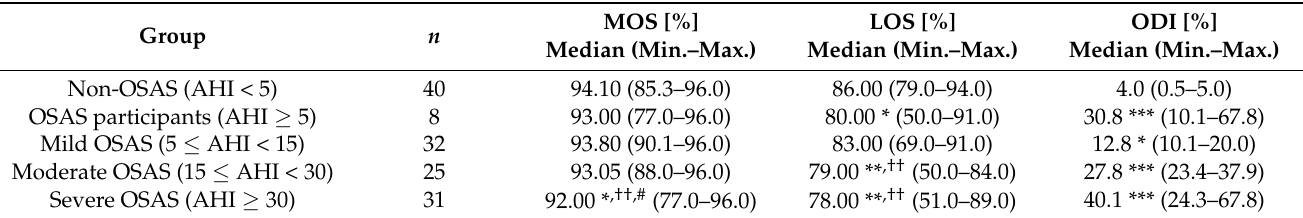
Table 4. Oxygen saturation level (MOS), lowest oxygen saturation level (LOS), and oxygen desaturation index (ODI) in the participants with obstructive sleep apnea syndrome (OSAS) and in non-OSAS participants.